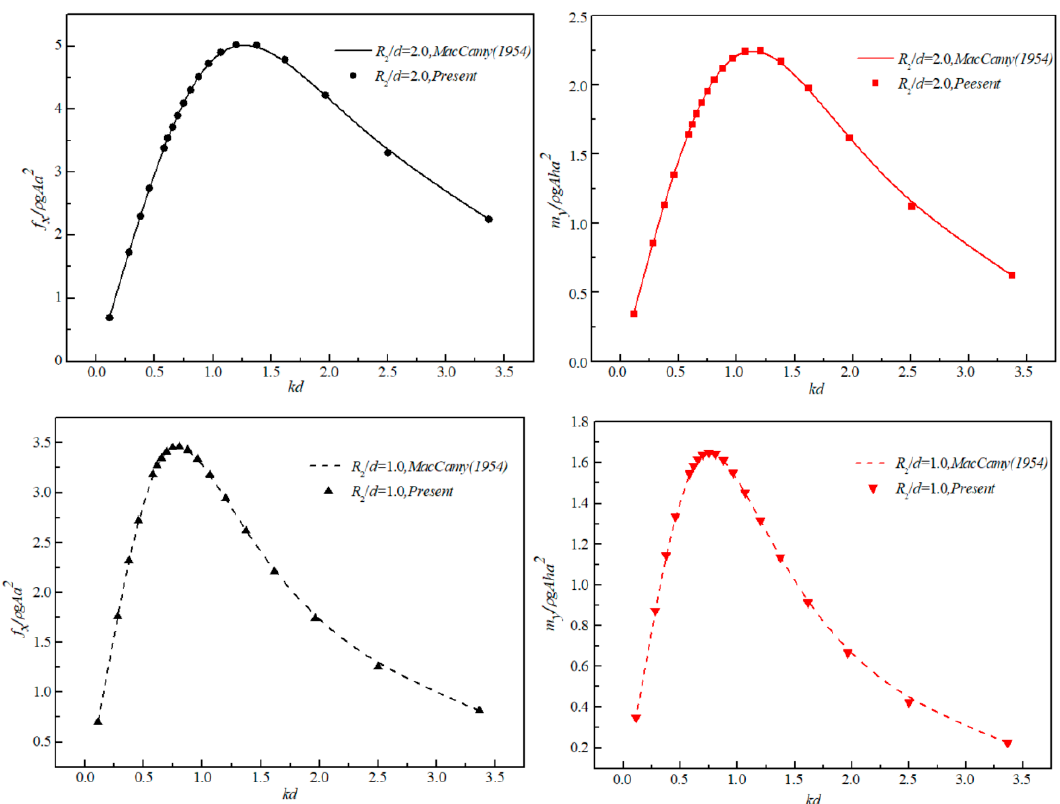
Figure 3. Comparisons of the wave force and wave moment between the present model and MacCamy’s results.